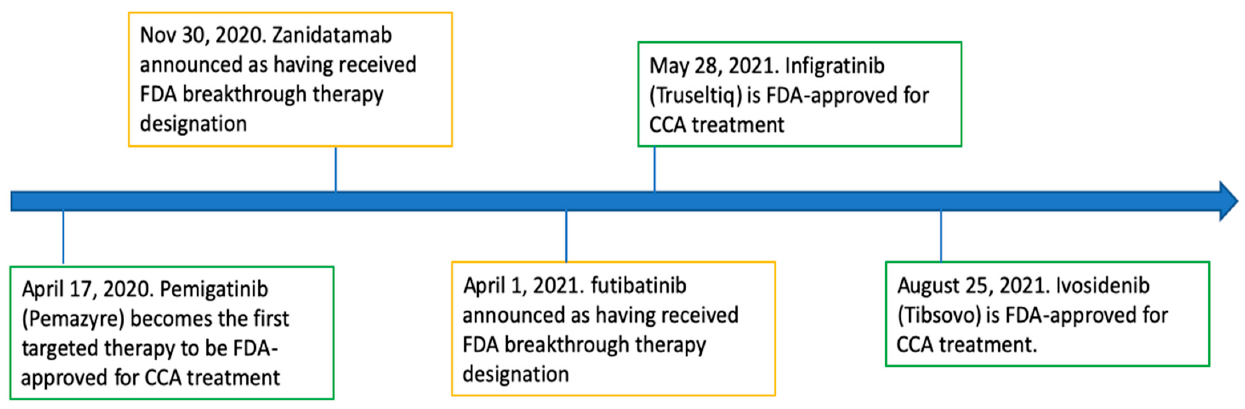
Figure 1. Timeline: targeted therapy with FDA approval or breakthrough therapy designation.